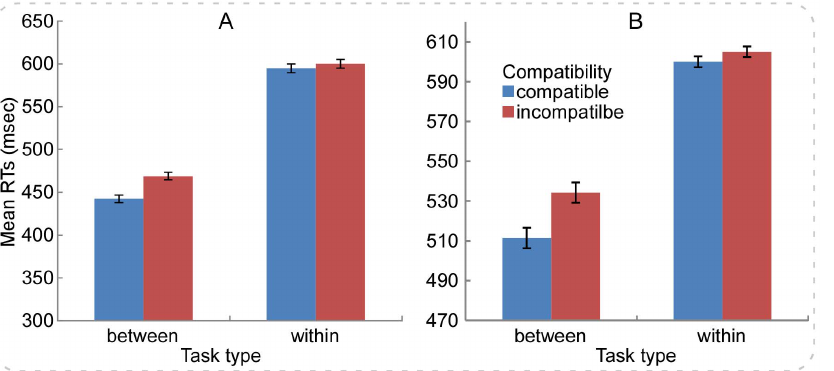
Figure 1. The RTs results for the between- and within-category Simon tasks in Experiments 1 and 2. Panel A illustrates that the Simon effect (incompatible minus compatible) is a function of task type ( between- and within-category color tasks) in Experiment 1. Notably, the Simon effect disappears in the within-category task but is observed in the between-category task. Panel B illustrates that the Simon effect is a function of task type ( between- and within-category shape tasks) in Experiment 2. As can be seen, the RTs patterns are extremely similar to those found in Experiment 1, i.e., the Simon effect disappears in the within-category task but is observed in the between-category task. Error bars indicate 6 1 standard errors of the mean ( SEM s) as calculated by the pairwise difference method ( SEM pairedDiff )